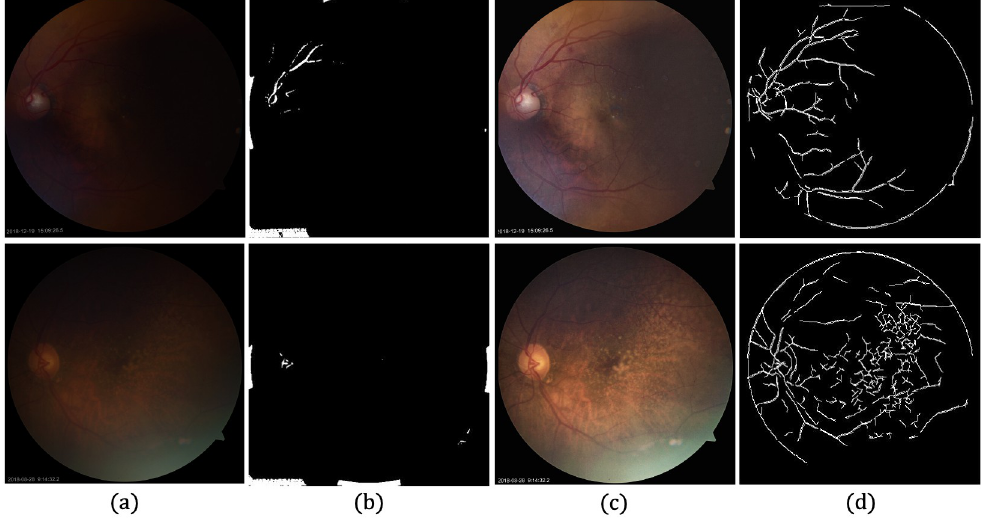
Fig 13. Segmentation of both LQ image and enhanced image. (a) Input LQ image. (b) Segmentation result corresponding to (a). (c) Enhancement result of (a). (d) Segmentation results corresponding to (c).